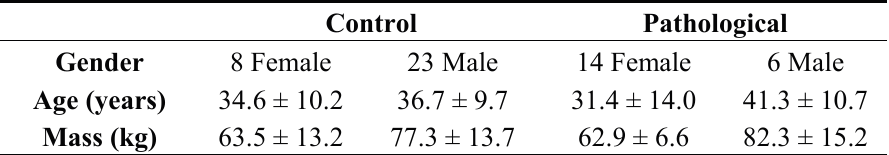
Table 1. Participant characteristics.